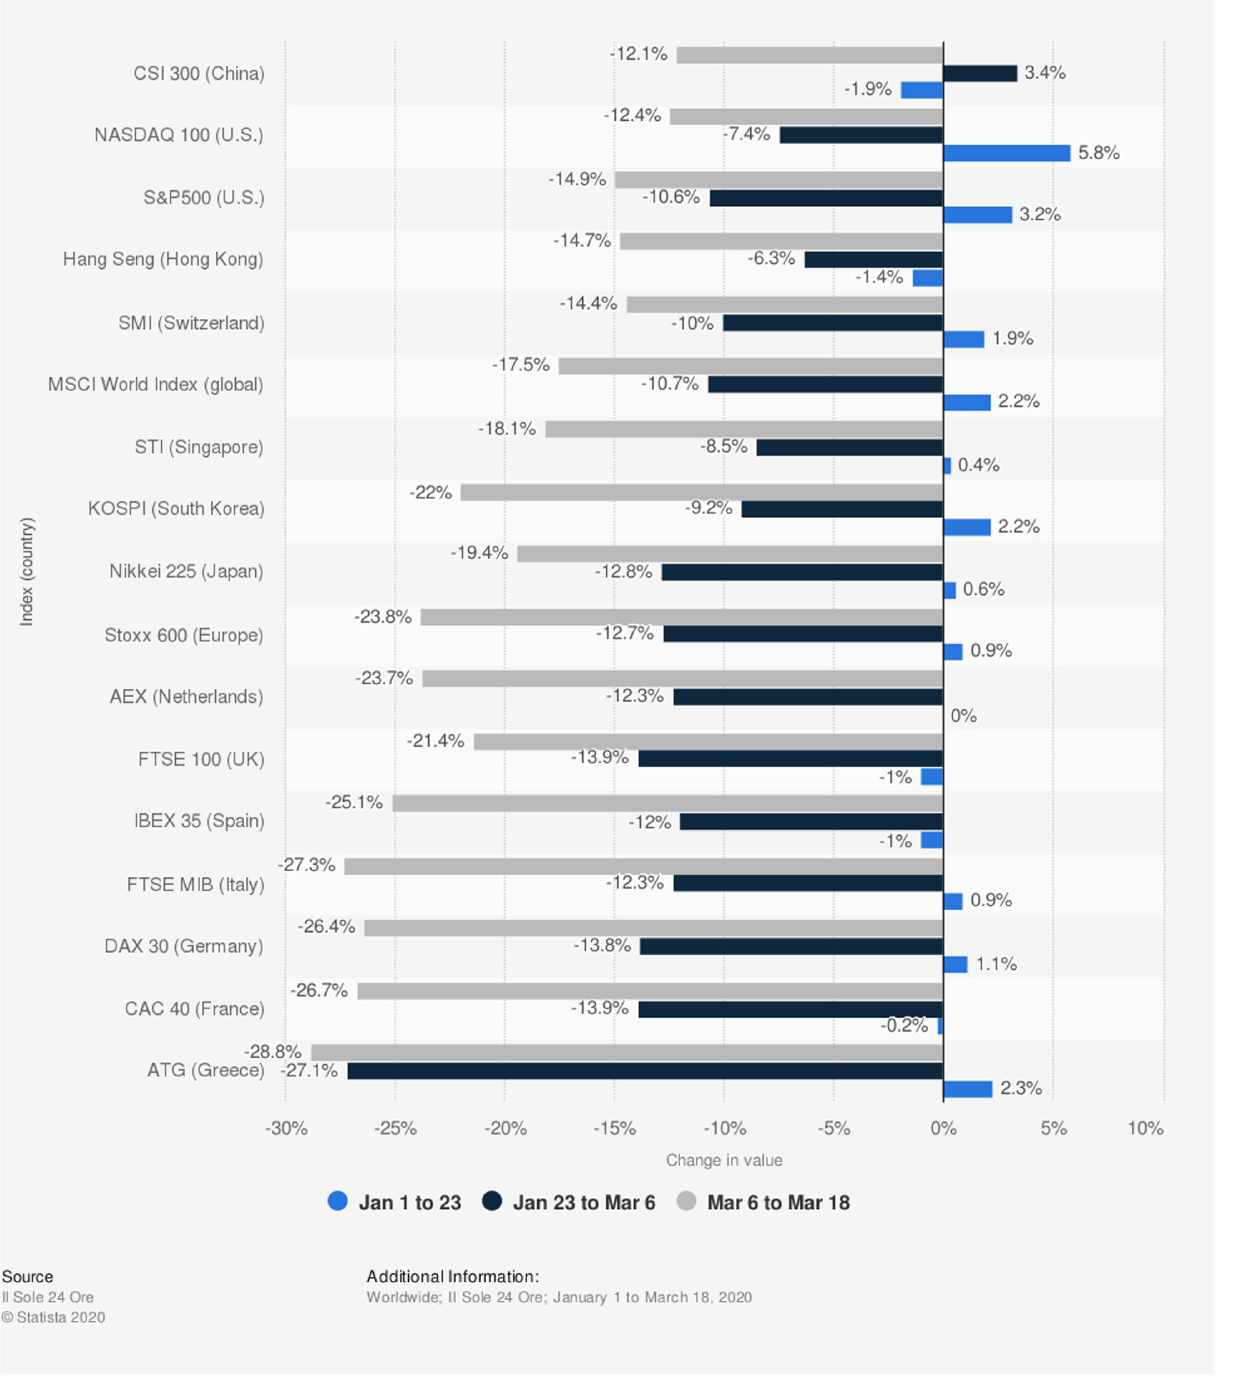
Frontiers in Psychology |